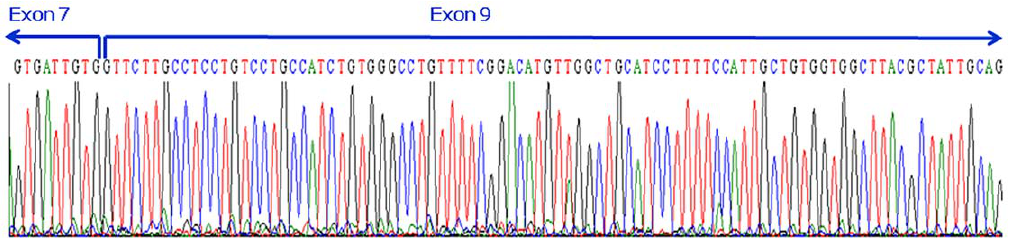
Figure 1. The Slc26a4 transcripts from the allele with the c.919-2A . G mutation lead to a complete omission of exon 8 during the splicing process in Slc26a4 tm1Dontuh/tm1Dontuh mice.